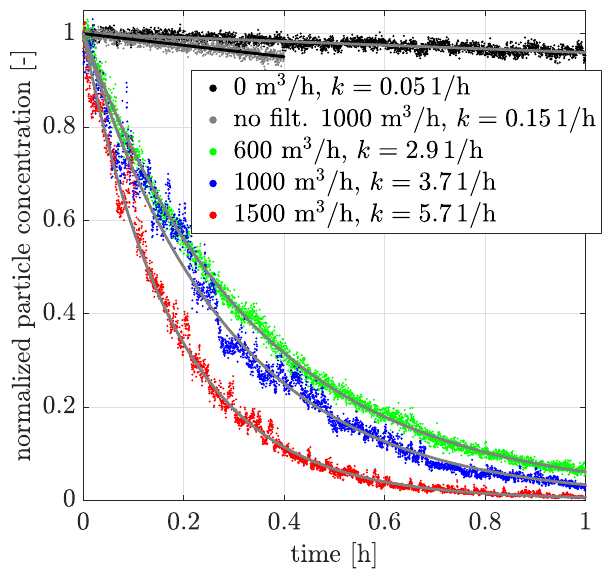
Figure 5. Normalized particle concentrations at mp3 ( config. I empty ) over time. Two reference cases are shown, i.e., air cleaner turned off (1, black dots) and air cleaner running at 1000 m³/h without any filters (2, gray dots). The 3 colored dots show the decay of the normalized particle concentrations over time at different volume flow rates. Increased flow rates result in increased k values, ranging from k = 2.9 1/h at 600 m 3 /h up to k = 5.7 1/h at 1500 m 3